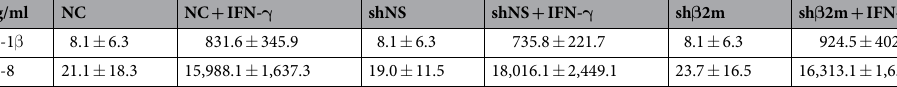
Table 1. Cytokine secretion profile.